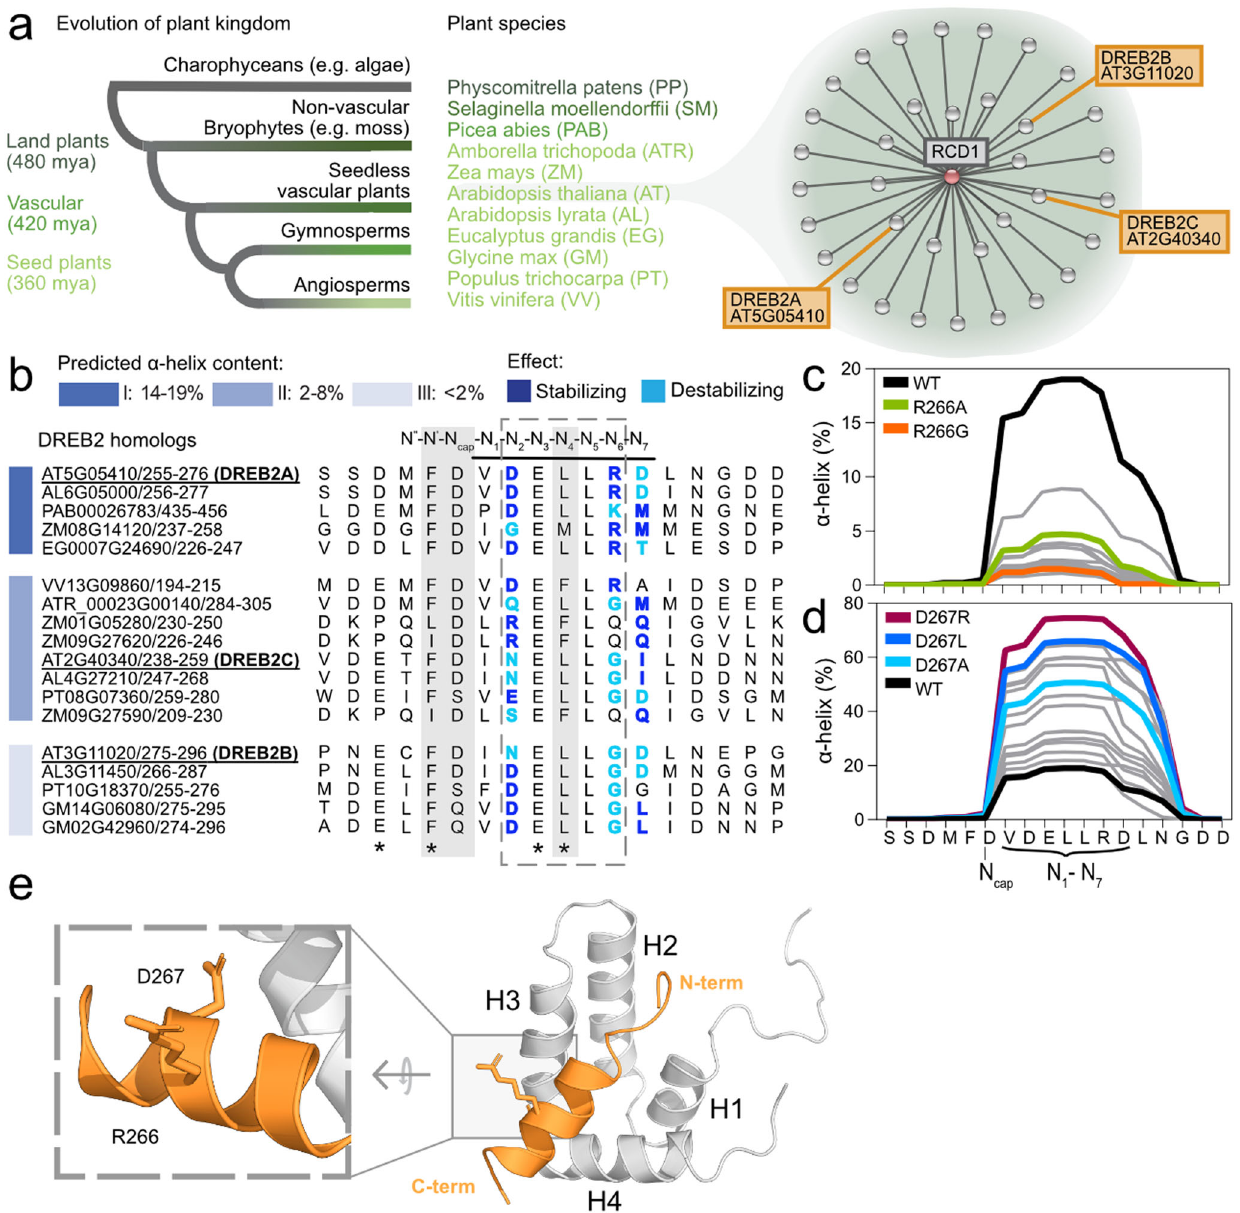
Fig. 1 Evolution, interactions, and structure of RCD1 and DREB2s guide selection of DREB2A variants with varying residual helicity. a Phylogenetic relationship of the plant kingdom with land plants divided into non-vascular (dark green) and vascular plants, which are further split into seedless (green) and seed plants, fi nally split into non- fl owering gymnosperms (light green) and fl owering angiosperms (lightest green). Species are listed in color corresponding to evolution. The Arabidopsis thaliana interactome of RCD1 obtained from the STRING database is highlighted to the right with DREB2s indicated. b Multiple sequence alignment of the RCD1-RST binding region of DREB2A homologs from different plant species. The aligned region corresponds to Arabidopsis thaliana DREB2A(255-272) (AT5G05410) with the RCD1-RST binding region underlined. Based on α -helix (%) predicted by Agadir, the sequences were assigned to three groups: I: 14 – 19%, II: 2-8%, and III: <2% (blue-colored horizontal bars at left). The α -helical region of free and RCD1-RST-bound DREB2A are marked by the dashed box and the black bar above the alignment, respectively 30 . The position of the hydrophobic stable motif is outlined at top with key stabilizing residues of the N cap boxed in gray and numbering according to N cap . Residues in the helical region are colored according to predicted α -helix stabilizing (dark blue) or destabilizing (light blue) effect based on Agadir predictions. SLiM residues are marked with black asterisks. Helicity predictions by Agadir of variants at positions R266 ( c ) and D267 ( d ) in DREB2A with DREB2A-WT in black. All nonaromatic amino acids are included (gray). The substitutions selected for experimental characterization are colored, and DREB2A-D267R is shown in purple. ( e ) HADDOCK model of DREB2A(255-272) (orange) in complex with RCD1-RST(499-572) (silver, PDB: 5oao) 25 with helix 1-4 (H1-H4) indicated. Left zoom shows surface exposure of D267 and R266 in